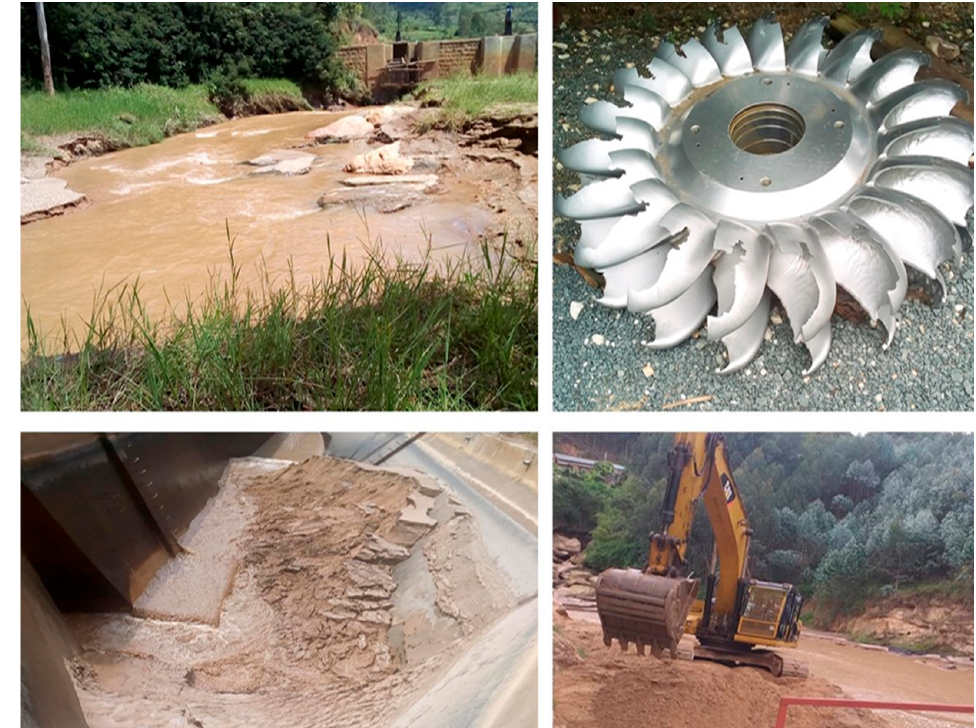
Figure 3. Field observation on soil erosion, sediments, and turbine wear. Clockwise from upper left: an upstream catchment filled with sediments and soil erosion during one rainy season, turbine runner wear due to waterborne sediment after 1.5 years in operation, heavy equipment removing sediments from another upstream catchment, and a sediment basin filled by sediments over three days during rainy season.